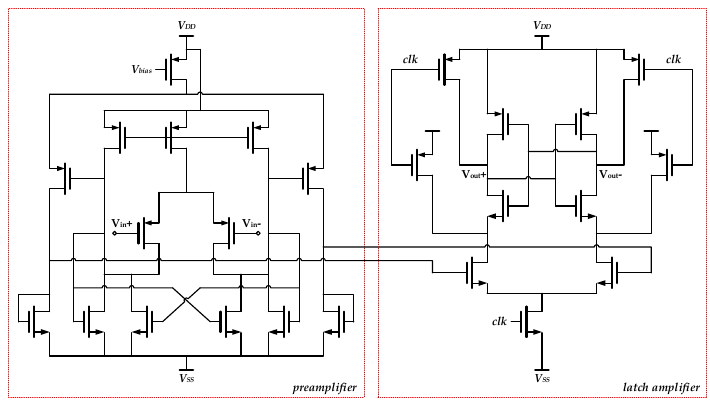
Figure 13. Schematic of dynamic latch quantizer in analog modulator.